Question: Condense the content of this figure into a single sentence.
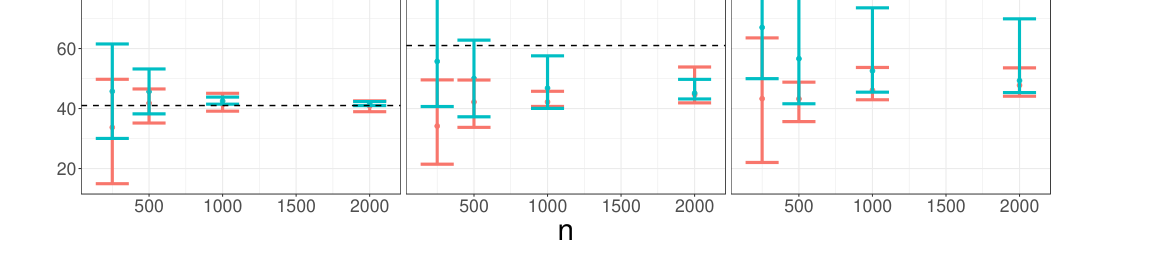
Answer: The average EDF and GDF values and their associated 2.5 and 97.5 quantiles versus sample size for different neural network architectures. The horizontal dashed line represents the number of parameters for each architecture.